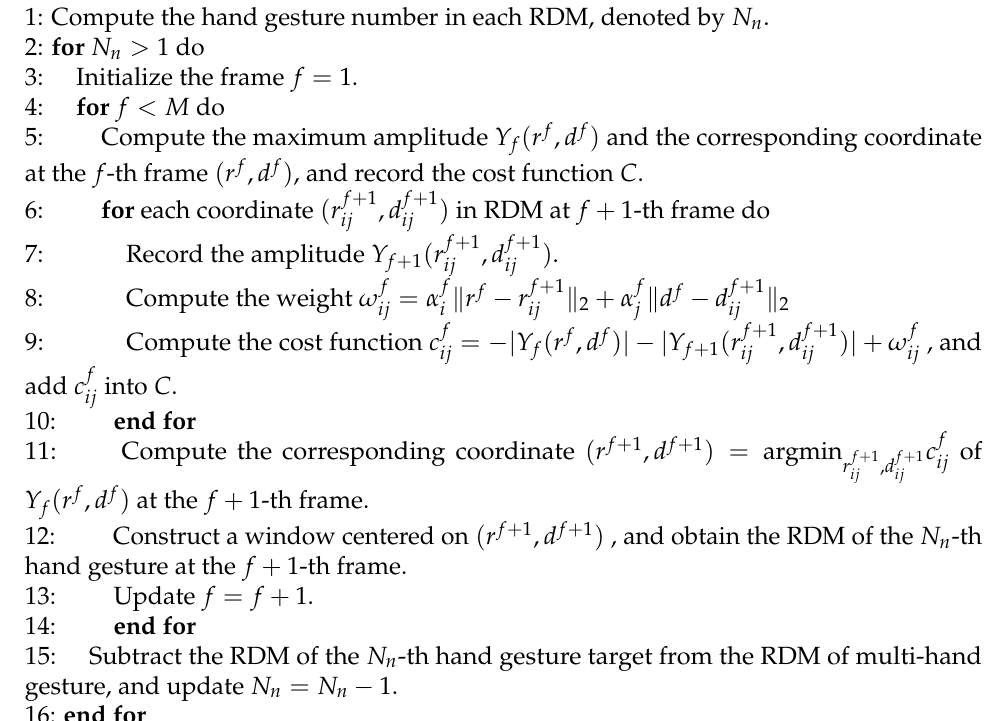
Algorithm 1 Spatiotemporal path selection algorithm for multi-hand gesture